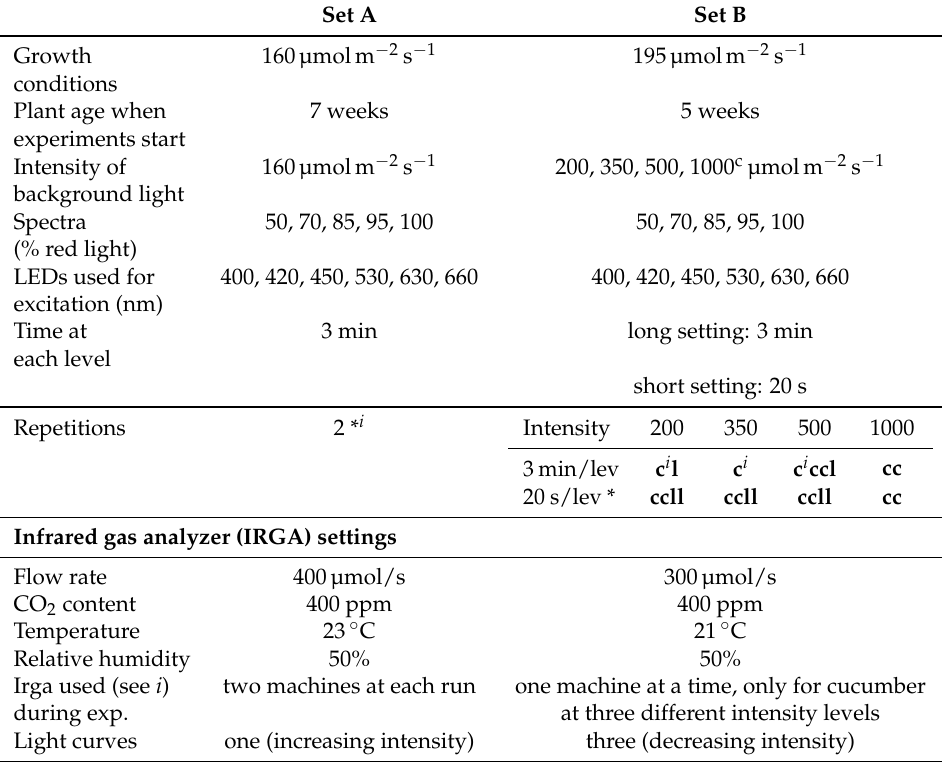
Table 1. Summary of the experimental